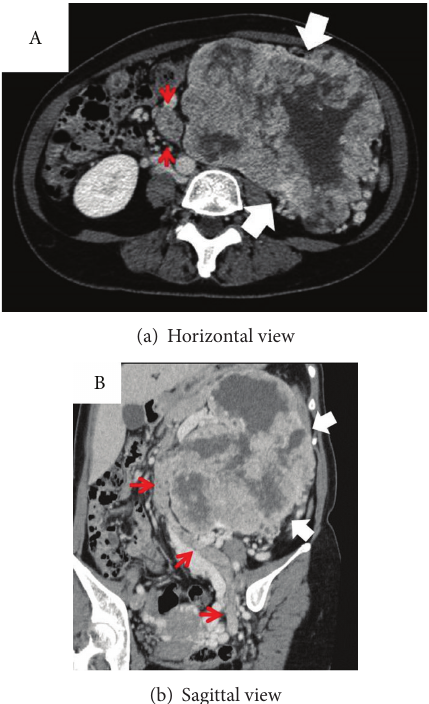
Figure 2: Contrast enhanced CT showed a left renal tumor with heterogenous enhancement (white arrows). Left ureter was packed with the tumor (red arrows).